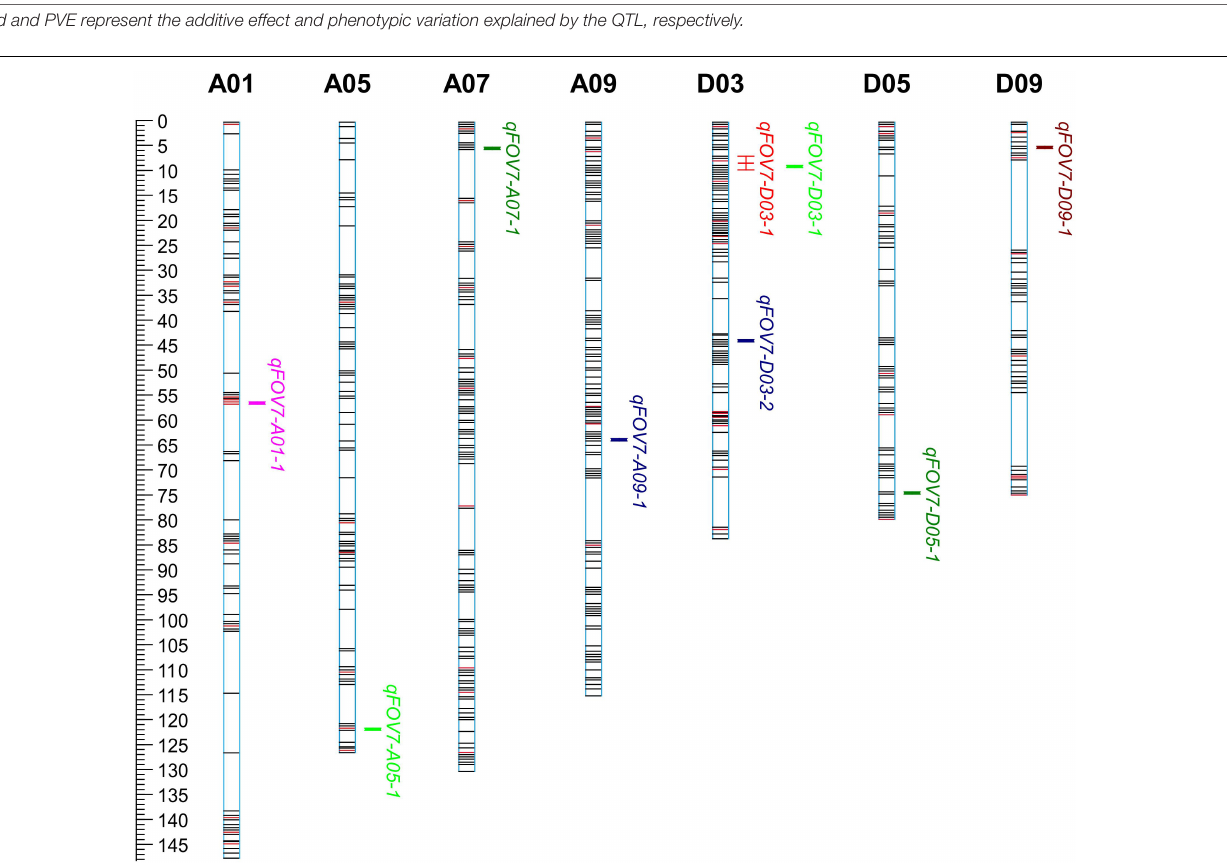
Frontiers in Plant Science |